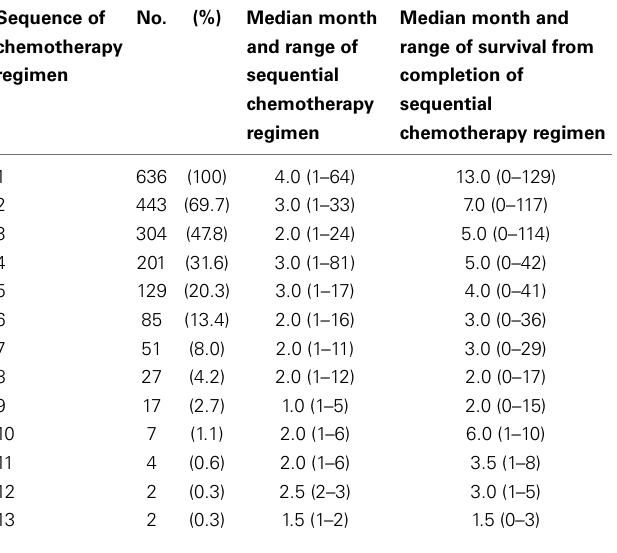
Table 2 | Distribution of treatment durations of sequential chemotherapy regimen and survival from completion of the sequential treatment.